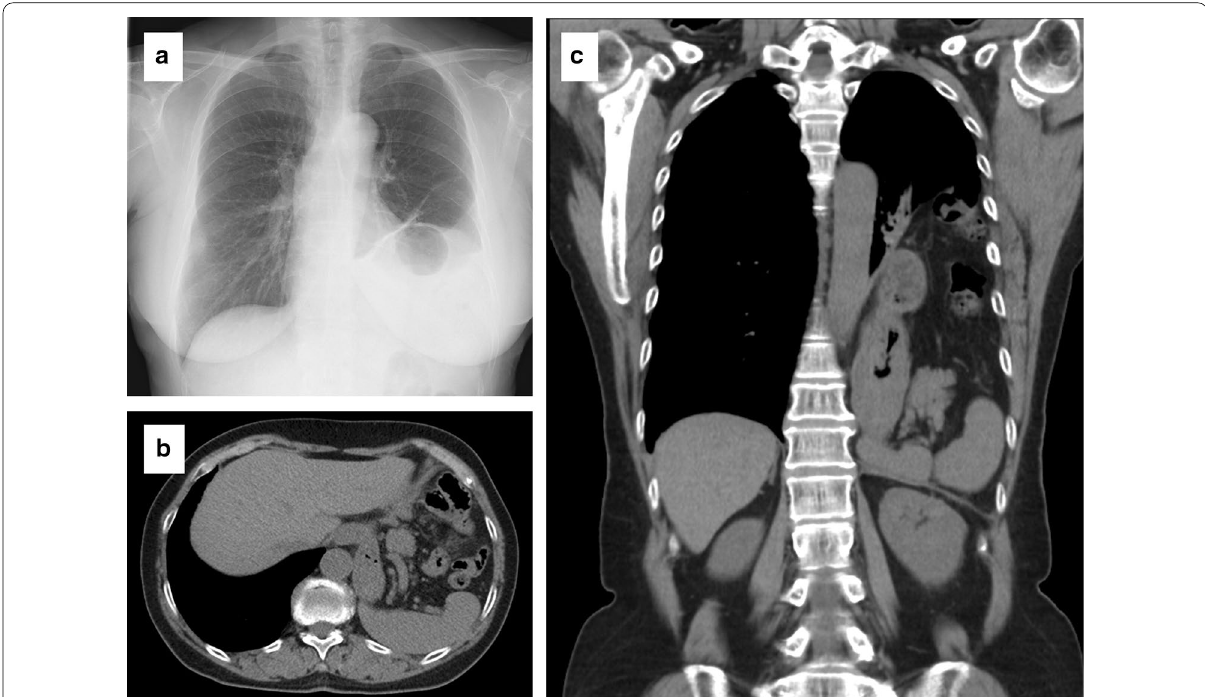
Fig. 1 a Preoperative images of the Bochdalek hernia. The chest radiography on admission shows a lesion containing bowel gas in the left thoracic cavity. b Axial view images of the CT scan showing prolapse of the stomach, small intestine, colon, pancreas, and spleen into the left thoracic cavity. c Coronal view images of the CT scan showing same as above